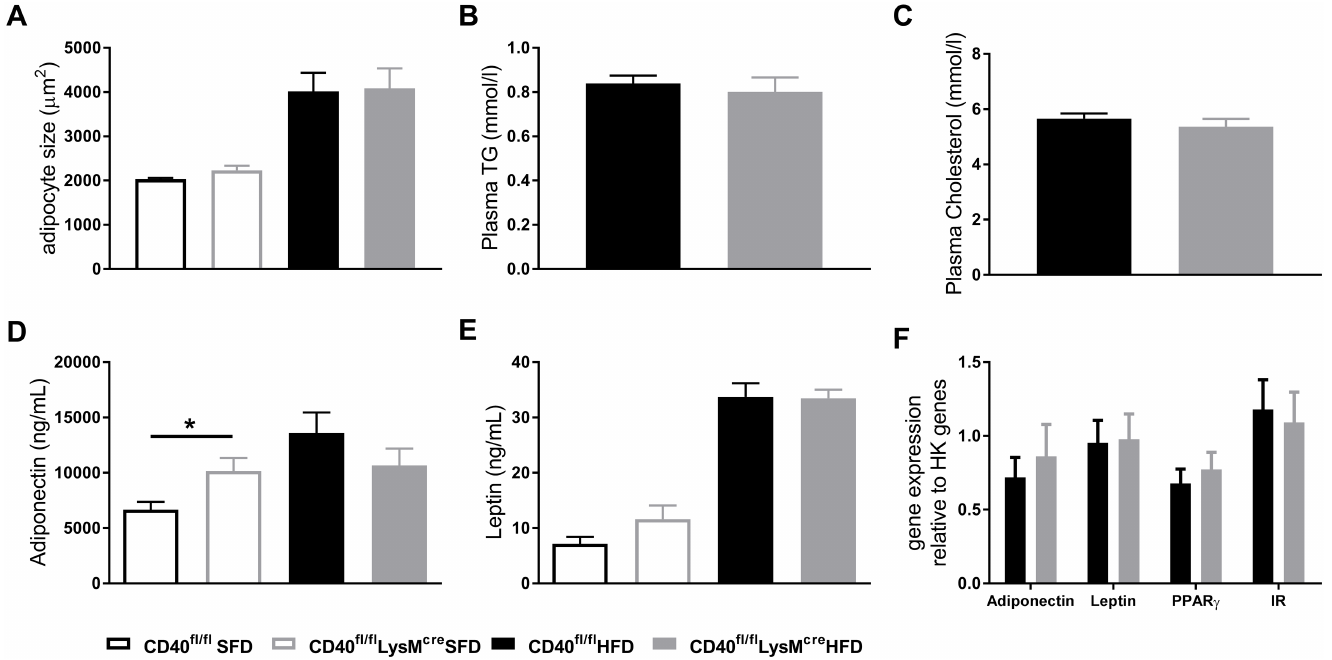
Fig 3. Adipose tissue function is not affected by macrophage CD40 deficiency. (A) Adipocyte size after 13 weeks of dietary intervention. (B) Plasma triglycerides (TG). (C) Plasma total cholesterol levels. (D) plasma adiponectin levels are increased in lean macrophage CD40 deficient mice but are not different in obese mice. (E) Plasma leptin levels. (F) mRNA expression of adiponectin, leptin, PPAR γ and insulin receptor (IR) in EpAT, (n = 6–9 mice/group). Data is presented as mean ± SEM. (cid:3) p < 0.05, as determined by non-parametric Mann Whitney test.